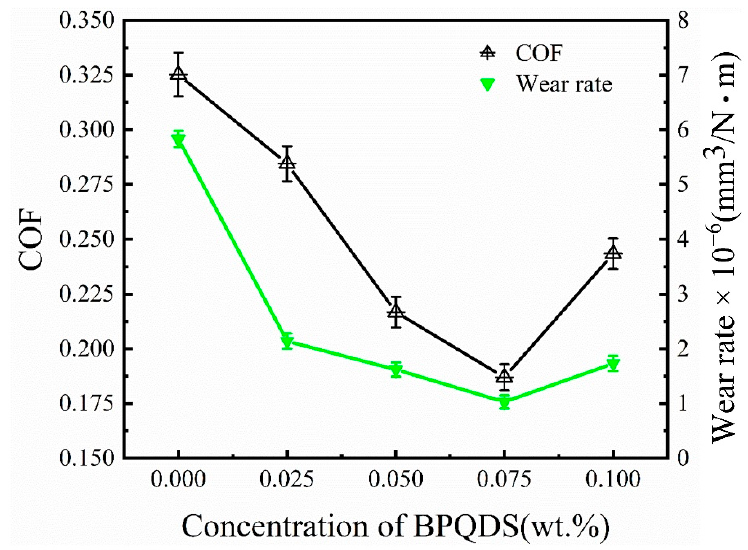
Figure 6. Average COFs and wear rates as a function of BPQDs concentration as water-based lubrication additives (10 N, 150 r/min, 0.5 h).